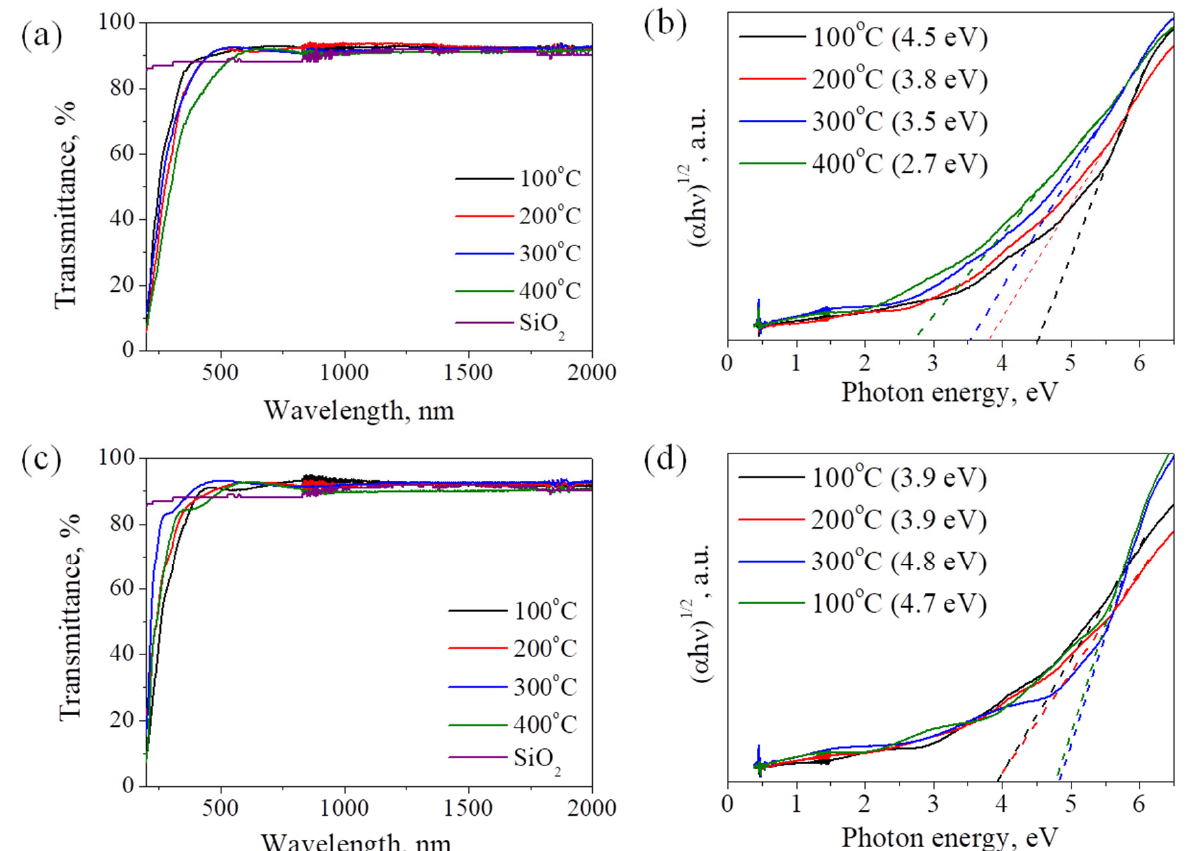
Figure 8. Transmittance and absorbance spectra in Tauc plots of SiCN films deposited using BTMSPA/He ( a , b ) and BTMSPA/NH 3 ( c , d ) mixtures. BTMSPA/He ( a , b ) and BTMSPA/NH 3 ( c , d )